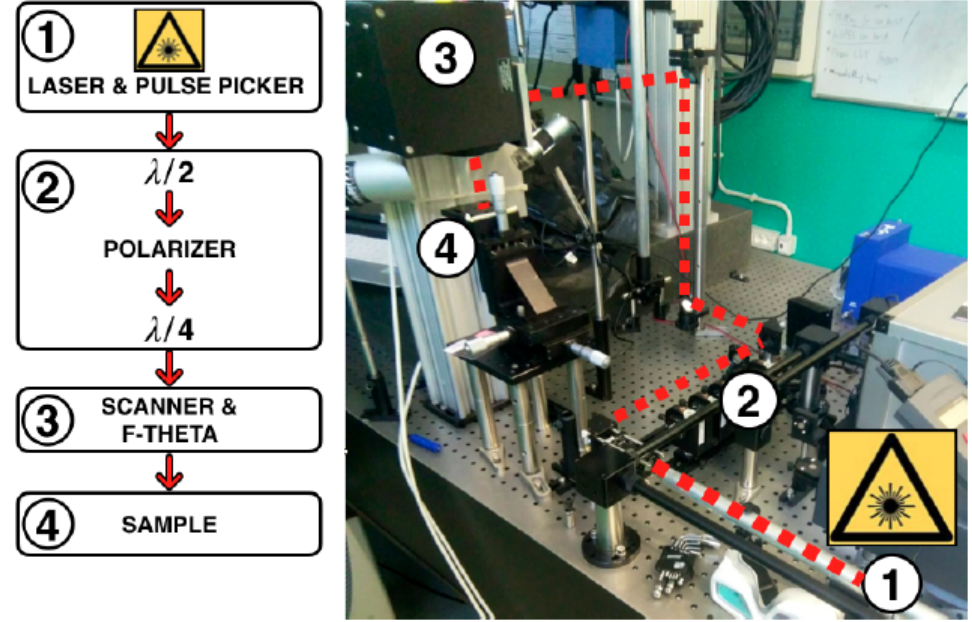
Figure 1. Experimental setup: from the pulse picker (1), the laser beam passes through a half wave-plate followed by a polarizer used to adjust the laser power finely, then its vertical polarization is converted in circular by using a quarter wave-plate (2). A system of mirrors directs the laser beam towards a galvo-scanner (3) which focuses the beam onto the sample